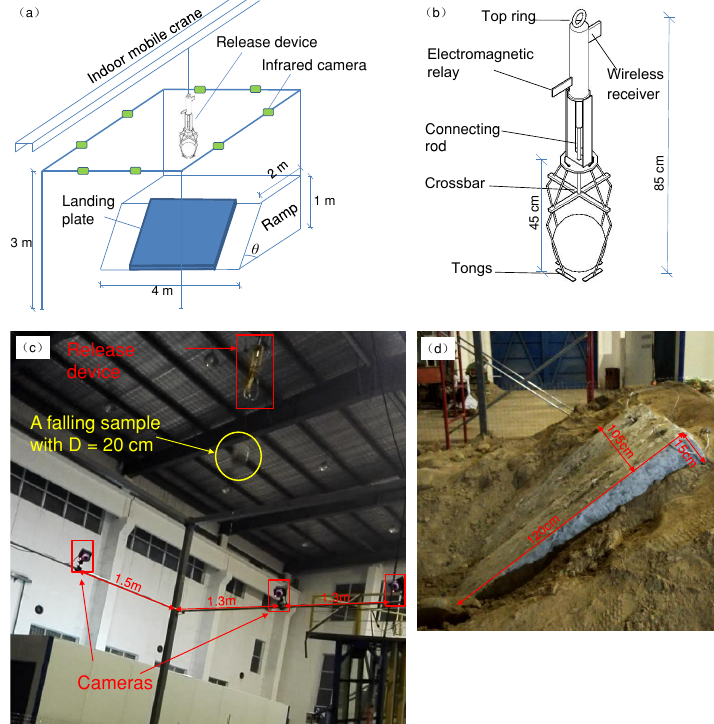
Figure 3. The testing apparatus in this study: (a) a general view of the apparatus, (b) a schematic representation of the specifically designed release device, (c) a falling sample after the wireless switch was turned on and (d) slabs to be replaced for excessive damage.